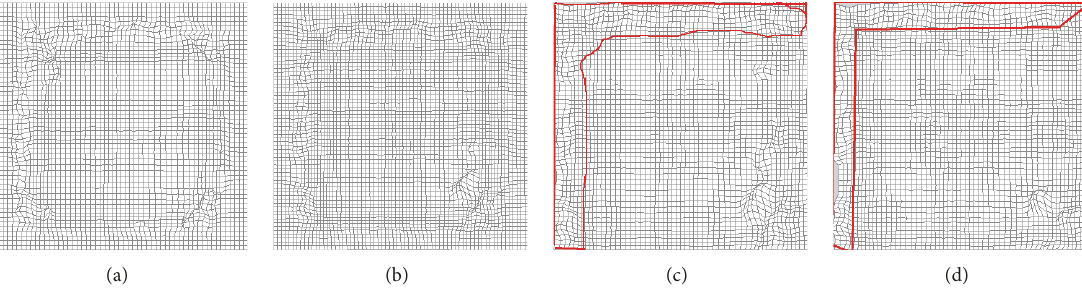
Figure 7: Deformation field. (a) Our method, (b) diffeomorphic demons, (c) additive demons, and (d) active